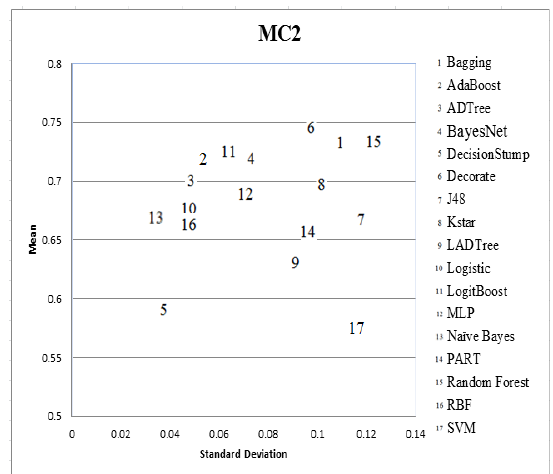
Figure 8. AUC mean value with 4 scenarios and deviation from mean in MC2 dataset